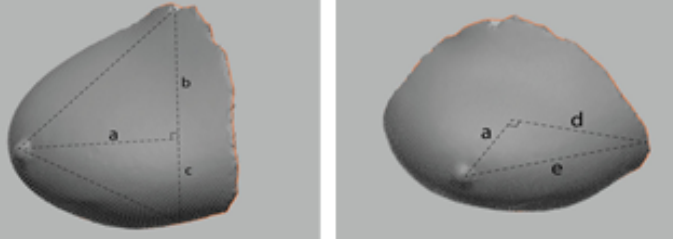
Figure 6. The 3D-SIM volume calculation.